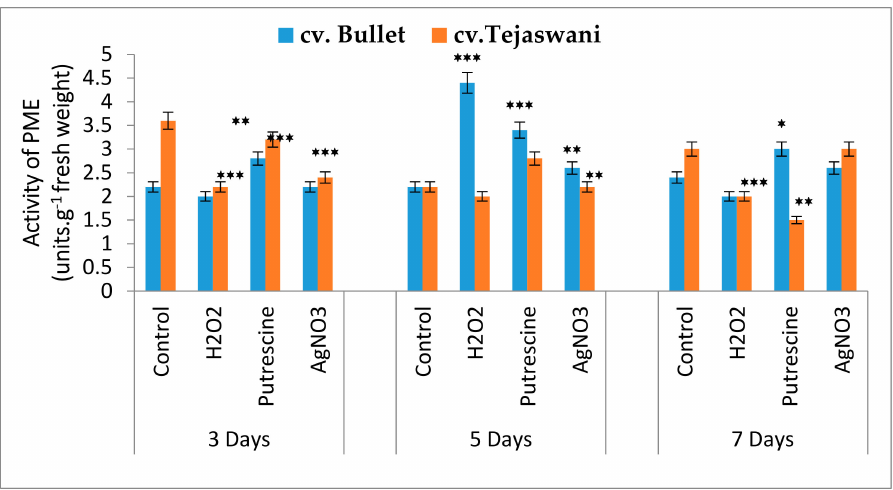
Figure 6. Assay of PME activity of two chili types, cv. Bullet and cv . Tejaswani, under different treatments (Control, H 2 O 2 , putrescine, and AgNO 3 ) and durations (3, 5, and 7 days). The vertical bars represent the data with the mean of three replicates with ± SE ( n = 3) from an individual set of experiments, and significant di ff erences between the treatments as calculated by a student’s t-test marked as * ( p ≤ 0.05) ** ( p ≤ 0.01) *** ( p ≤ 0.001).